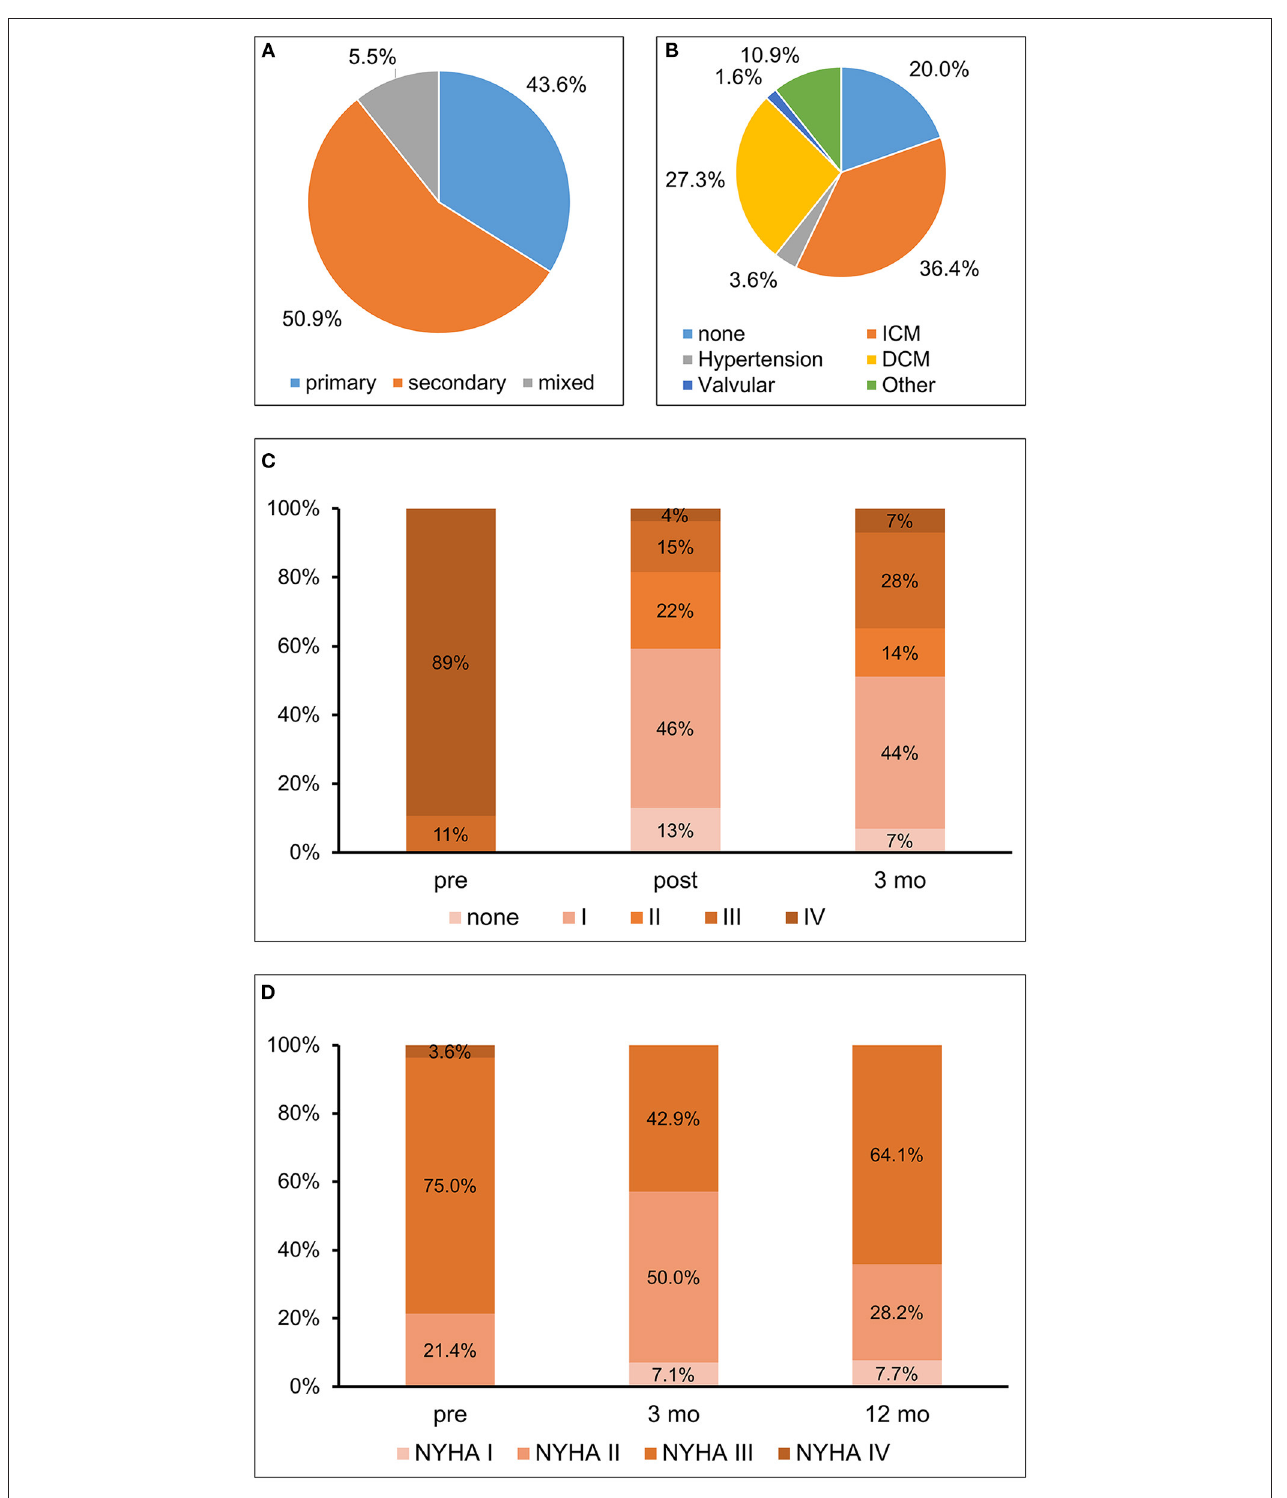
FIGURE 1 | (A) Etiology of mitral regurgitation; (B) Etiology of left ventricular dysfunction; (C) Mitral regurgitation–Severity of mitral regurgitation at baseline (pre), post procedural, i.e., at dismission (post), and 3 months (3 mo) after percutaneous mitral valve repair (PMVR); (D) Functional capacity–Assessment by New York Heart Association (NYHA) class before (pre) as well as at 3 months (3 mo) and 1 year (12 mo) after PMVR. ICM, ischemic cardiomyopathy; DCM, dilative cardiomyopathy.